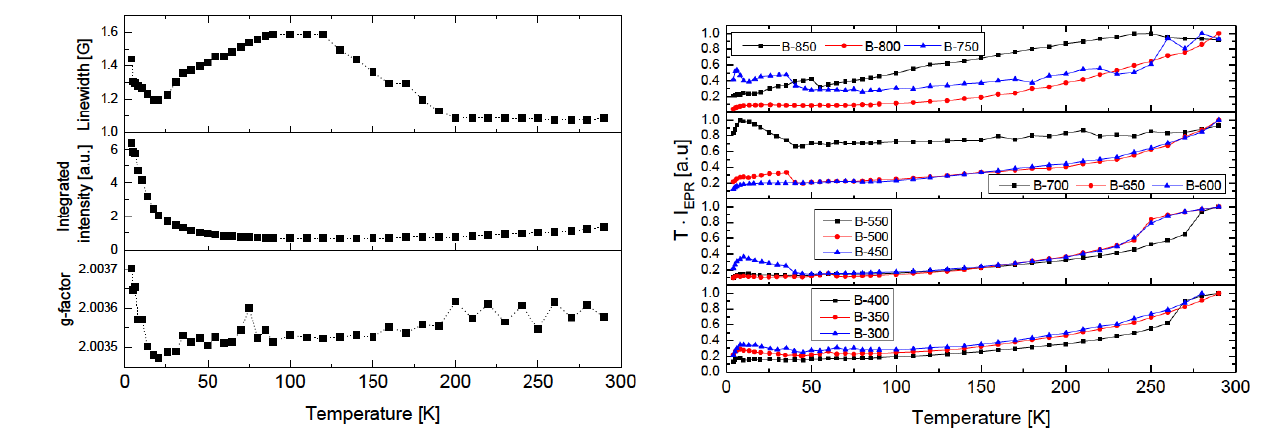
Figure 9: Temperature dependence of linewidth (top panel), inte- grated intensity (middle panel) and effective g -factor (bottom panel) for the N component in B-850 sample.